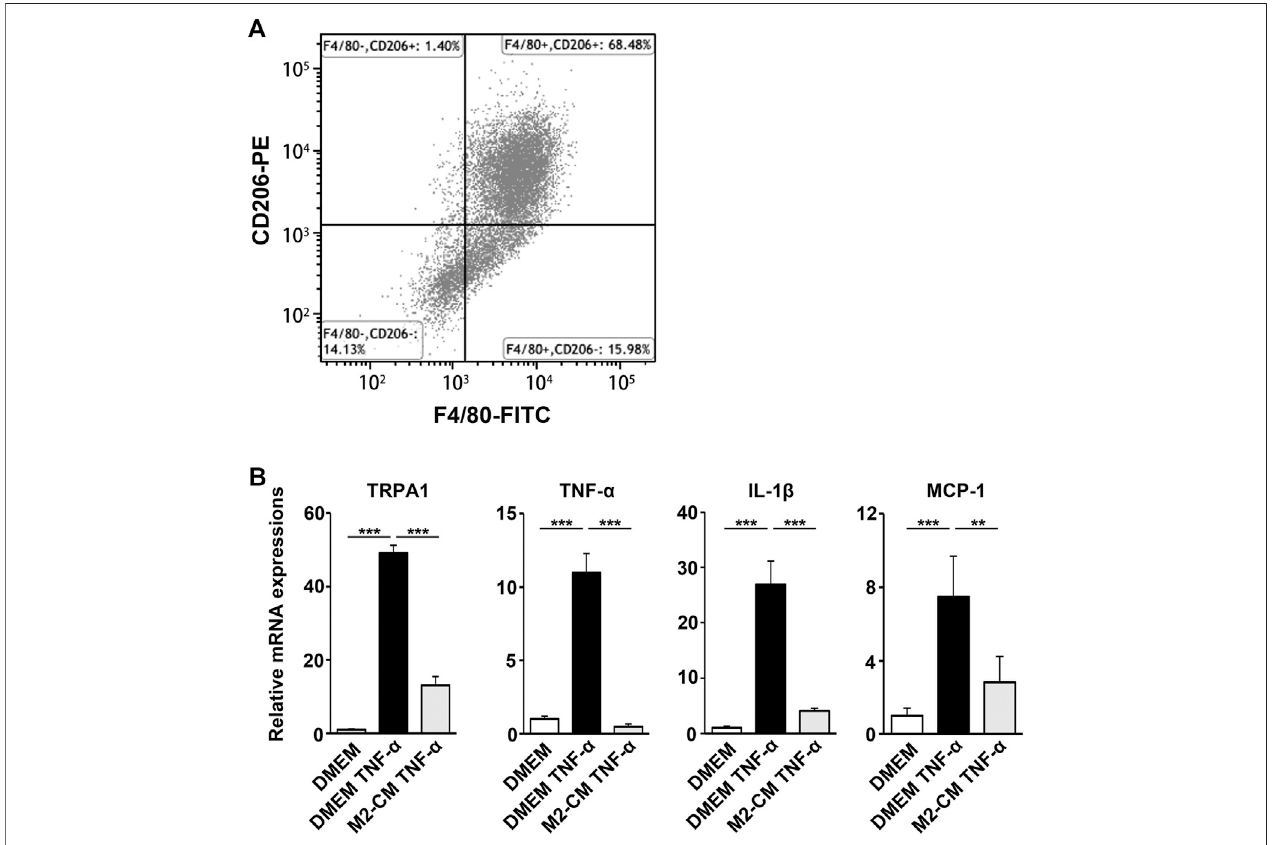
FIGURE 8 | M2-CM suppresses the pro-nociceptive properties of TNF- α -activated Schwann cells in vitro . (A) Flow cytometry analysis of SHED-CM-induced M2 polarization. Mouse bone marrow-derived macrophages were treated with SHED-CM for 24 h and stained with F4/80 and CD206 antibodies. (B) qPCR analysis of human Schwann cells treated with TNF- α with or without M2-CM. Notably, M2-CM strongly inhibited the TNF- α -mediated elevation of pro-nociceptive factors and channels in Schwann cells. Tukey multiple comparisons of means ( n = 3, per group). Data represent the mean ± SD; ** p < 0.01, *** p < 0.001.